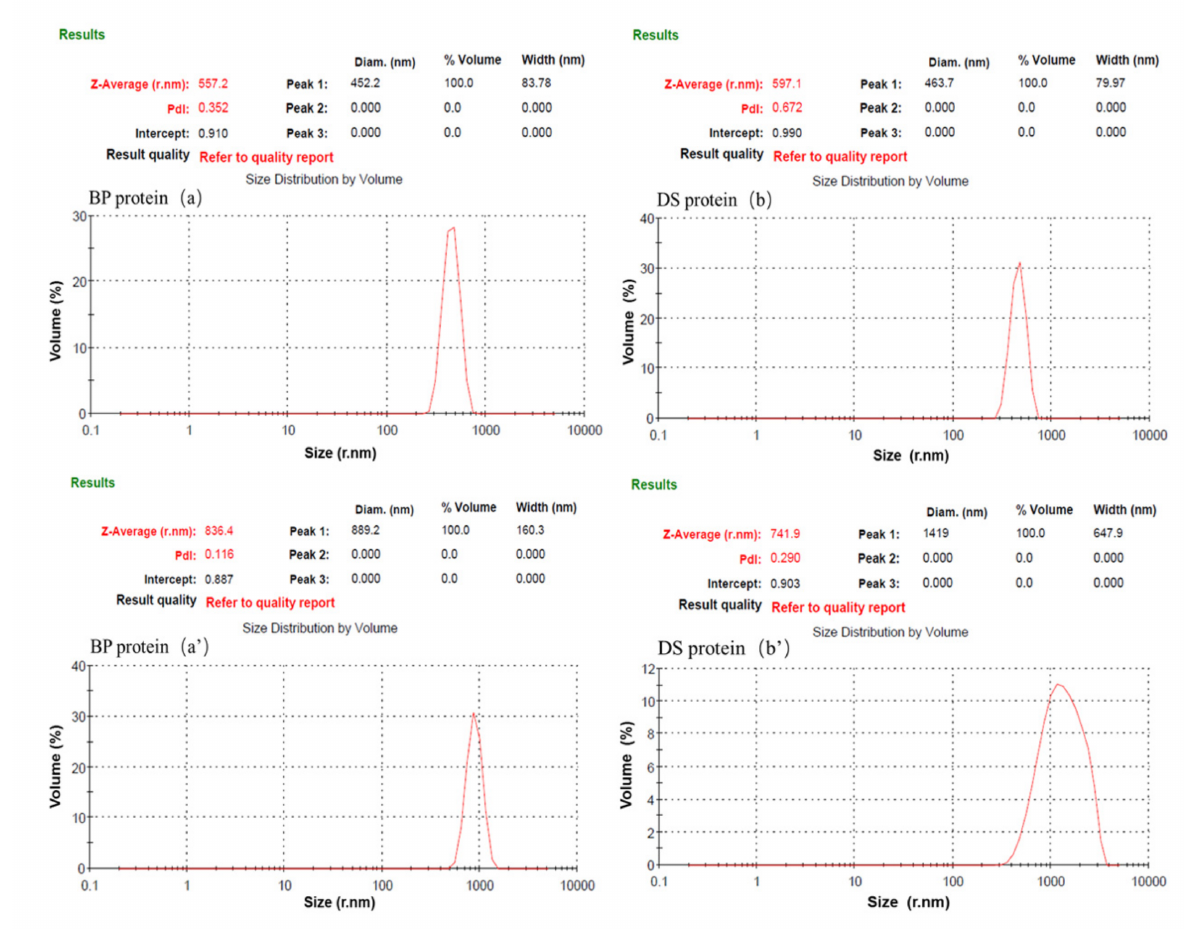
Figure 5. Premodification and postmodification of BP ( a , a’ ) and DS protein adhesives ( b , b’